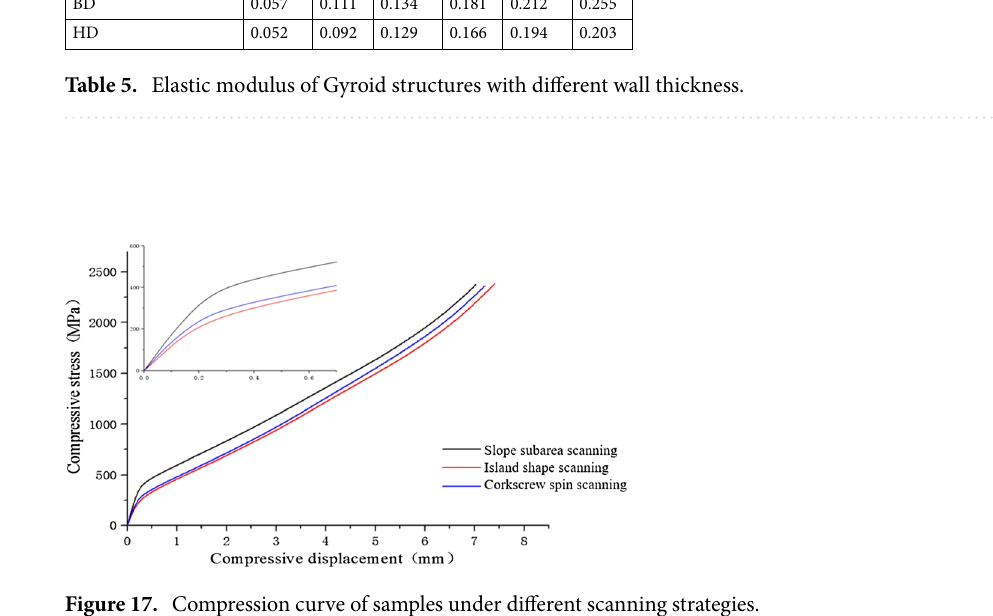
Figure 17. Compression curve of samples under different scanning